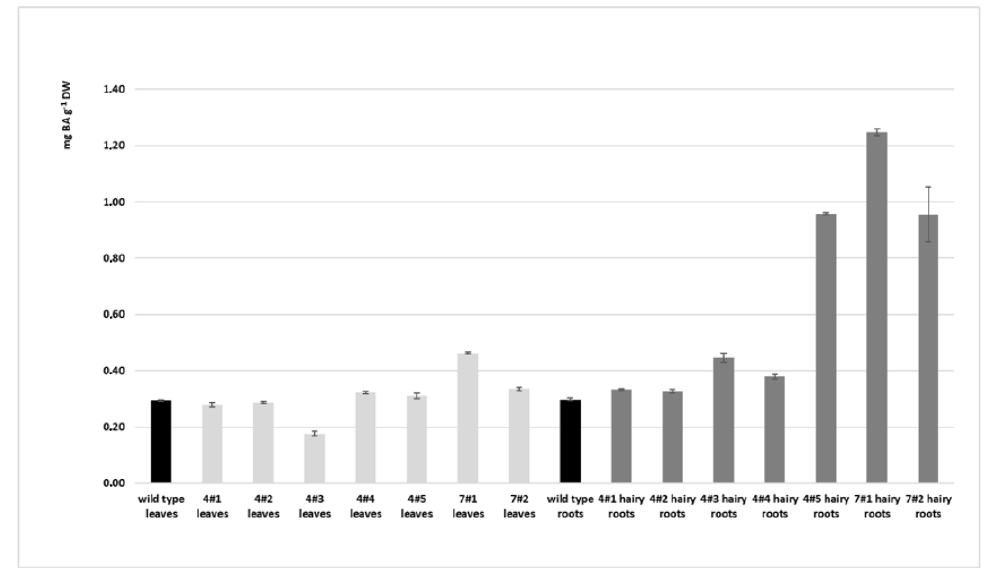
Figure 4. Total triterpene content determined in the investigated hairy roots and composite plants of S. purpurea . The analyses were performed as described in Section 2. The data ( ± SD) resulted from three samples per line.